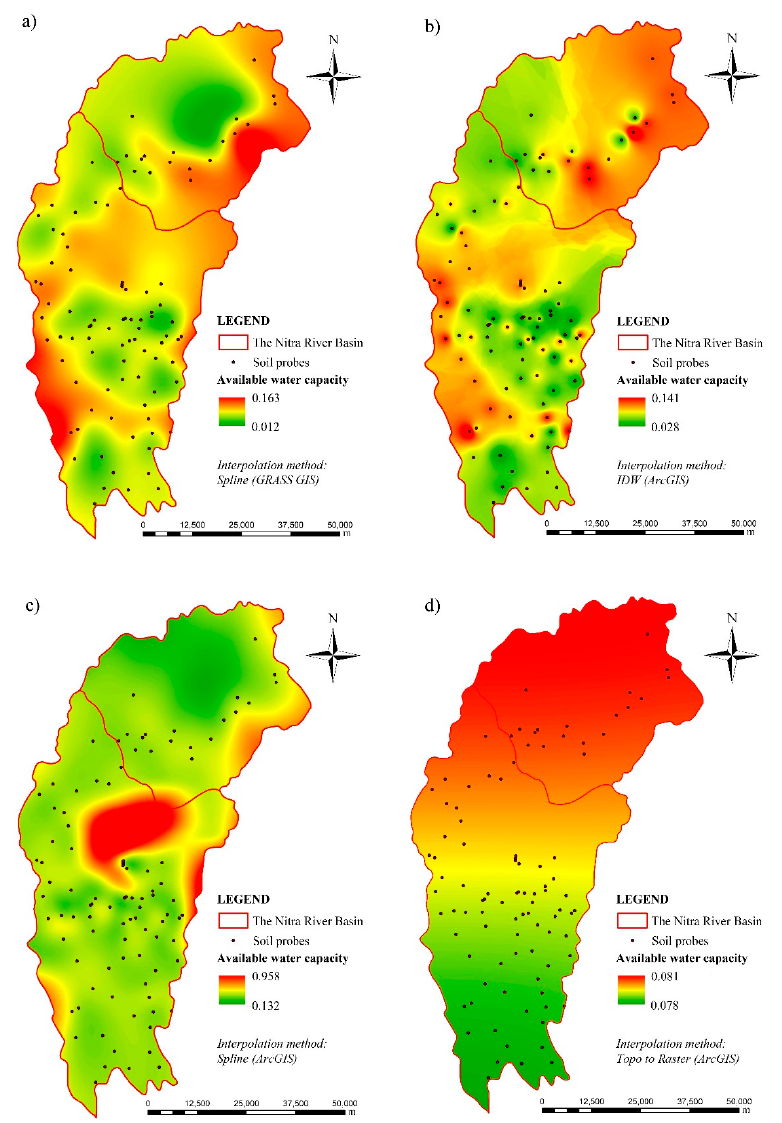
Figure 2. Spatial distribution of available water capacity according to used interpolation methods: ( a ) Spline (GRASS GIS); ( b ) IDW (ArcGIS); ( c ) Spline (ArcGIS); ( d ) Topo to Raster (ArcGIS).